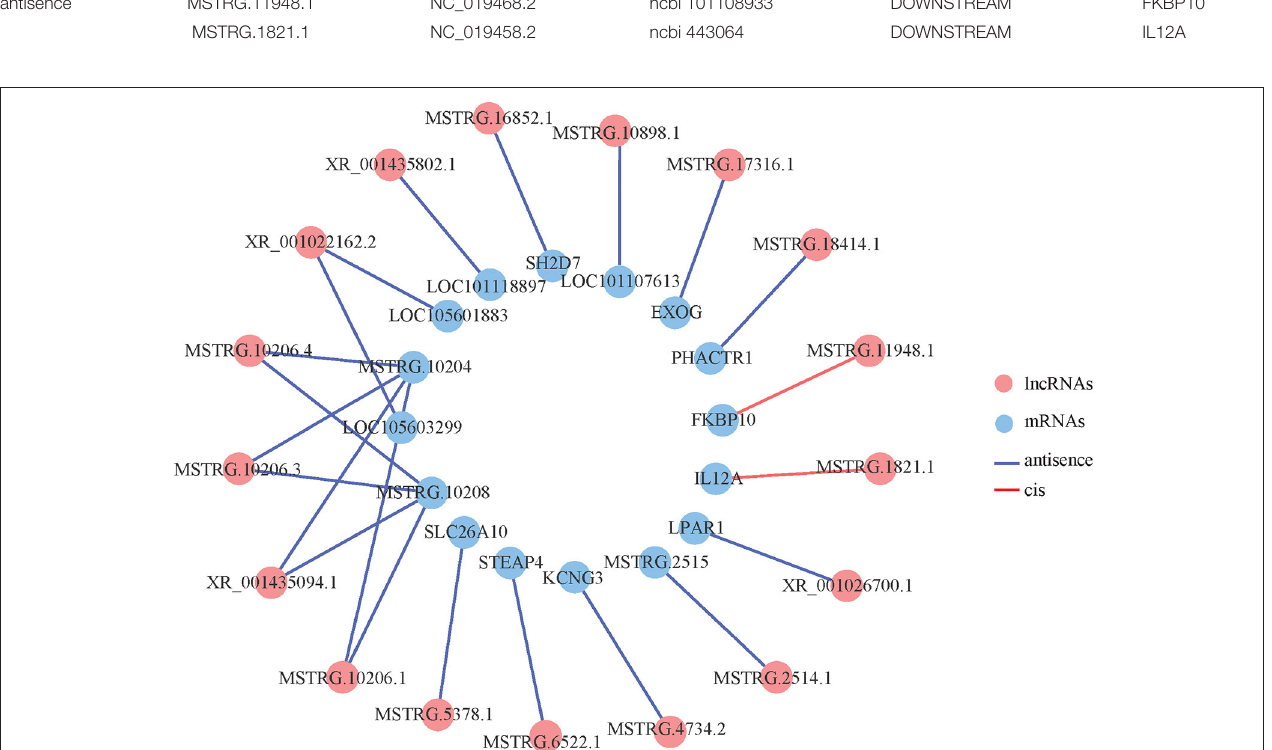
FIGURE 3 | Co-expression network of differentially expressed lncRNAs and differentially expressed mRNAs.